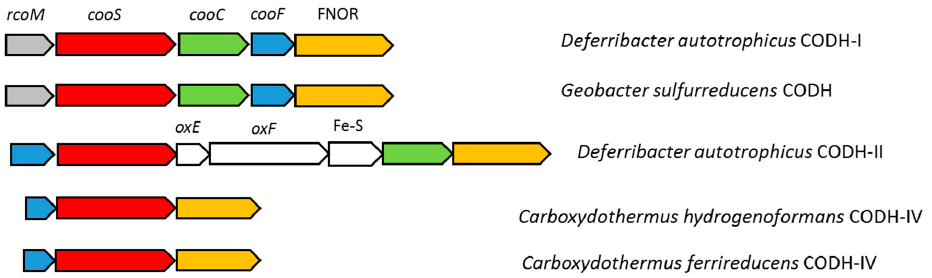
Figure 4. Carbon monoxide dehydrogenase gene clusters in D. autotrophicus and similar gene clusters present in other organisms. The genes of the following proteins are highlighted: rcoM, CO-sensing transcriptional regulator; coos, CO dehydrogenase catalytic subunit; cooC, accessory protein; cooF, Fe–S cluster—binding protein; FNOR, FAD–NAD oxidoreductase; oxE and oxF,